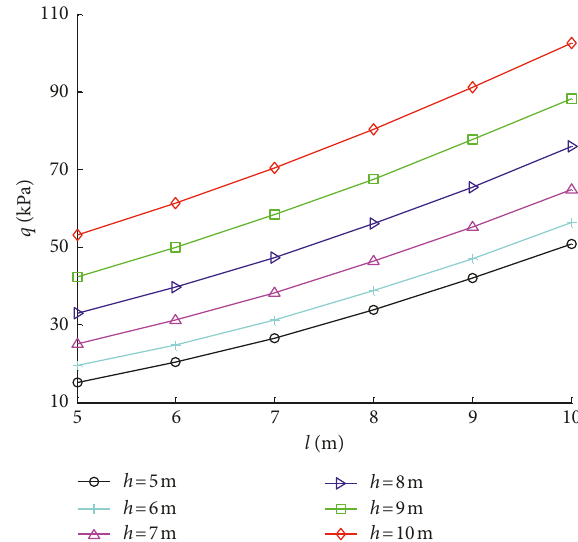
Figure 6: Effect of l and h on the surrounding rock pressure q .